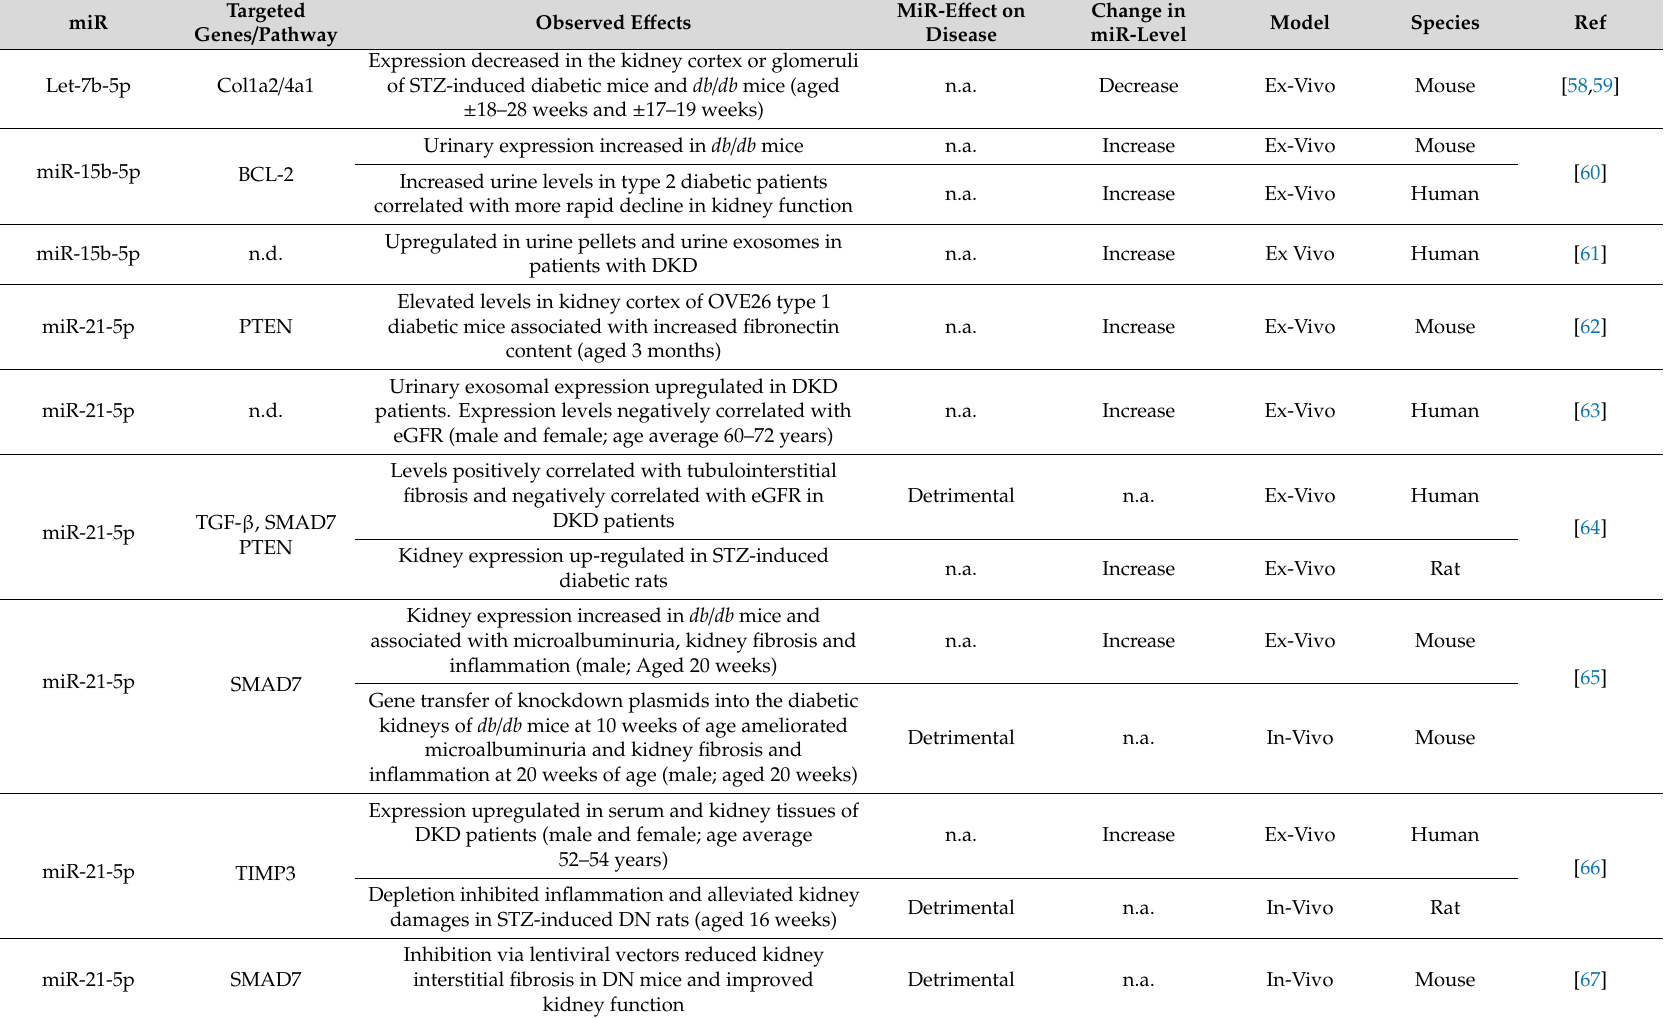
Observed E ff ects